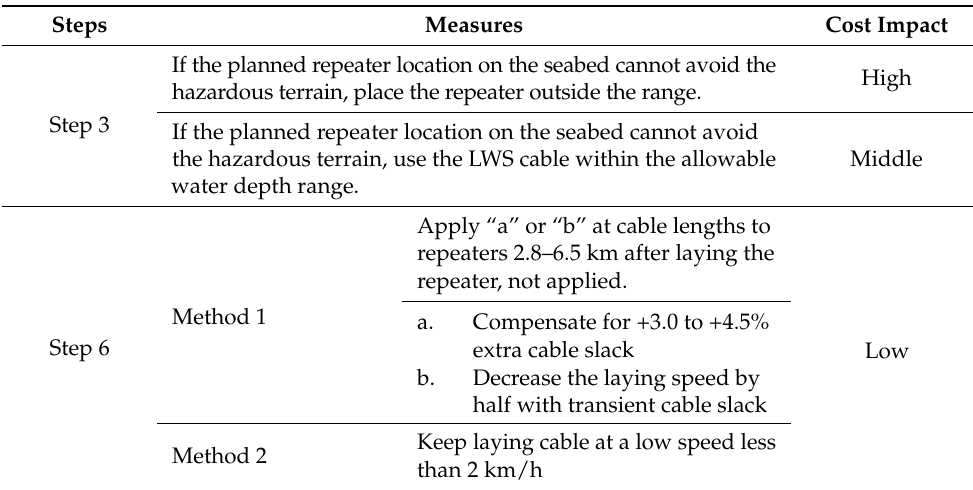
Table 4. Comparison of measures and cost impact on construction